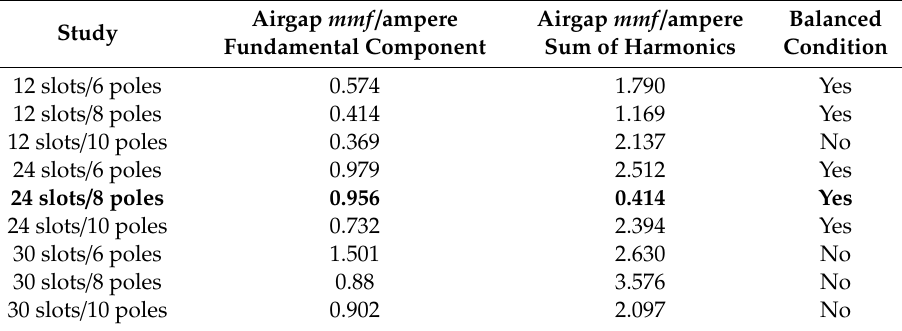
Table 5. Motor winding layout analysis